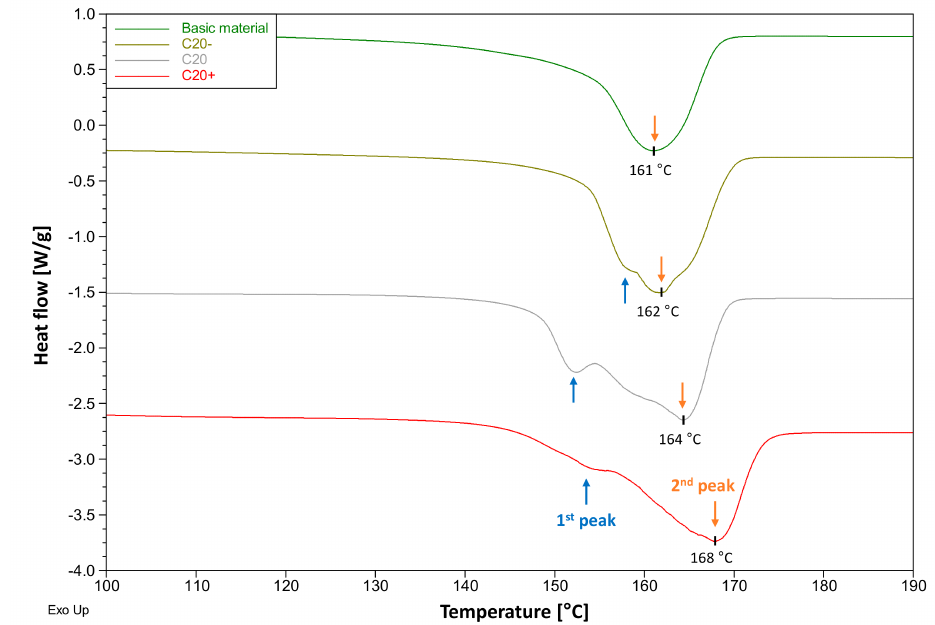
Figure 6. Influence of the drawing parameters on crystallization behavior during melt-spinning; comparison of the melt peaks determined by differential scanning calorimetry (DSC) for basic PP material (2nd heating), and PP fibers C20 − , C20 and C20+ with increasing draw ratio (1st heating).